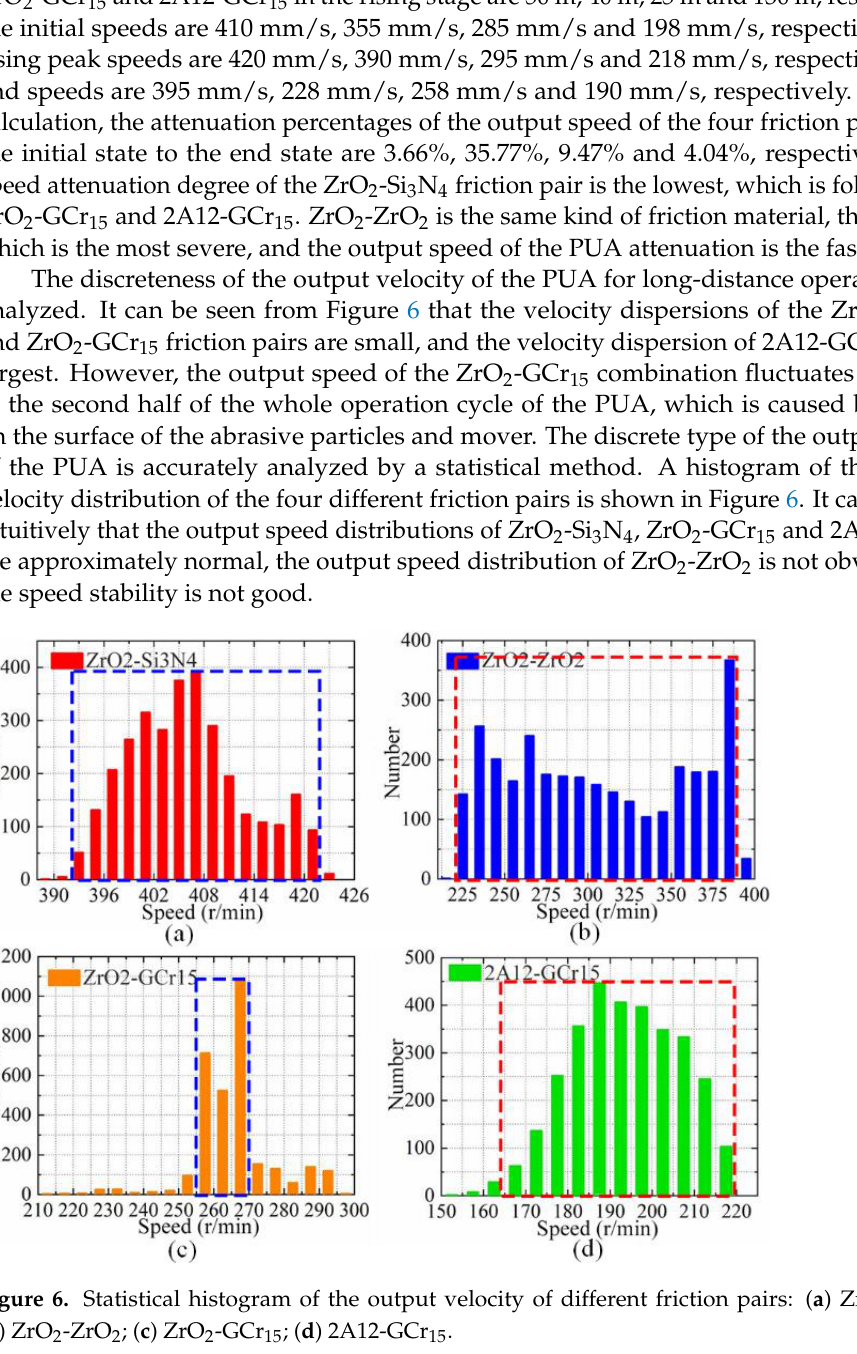
Figure 5. Output speed stability experiment under long-term operation (500 m).